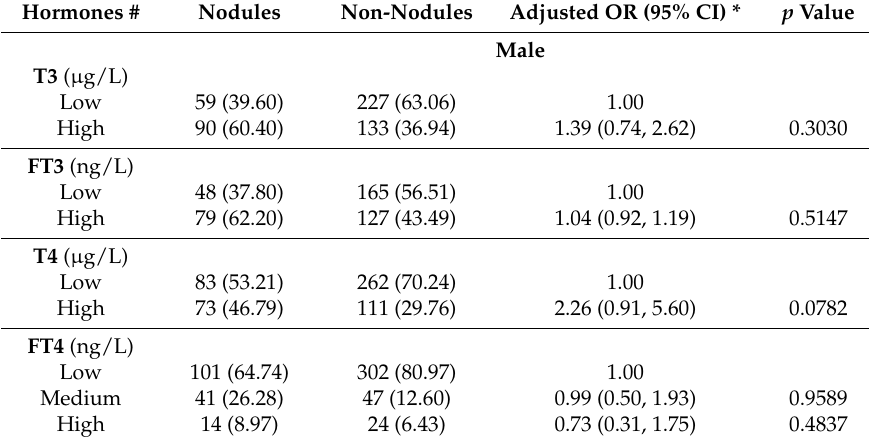
Table 4. Logistic regression to estimate the correlation between thyroid hormones and thyroid nodules among